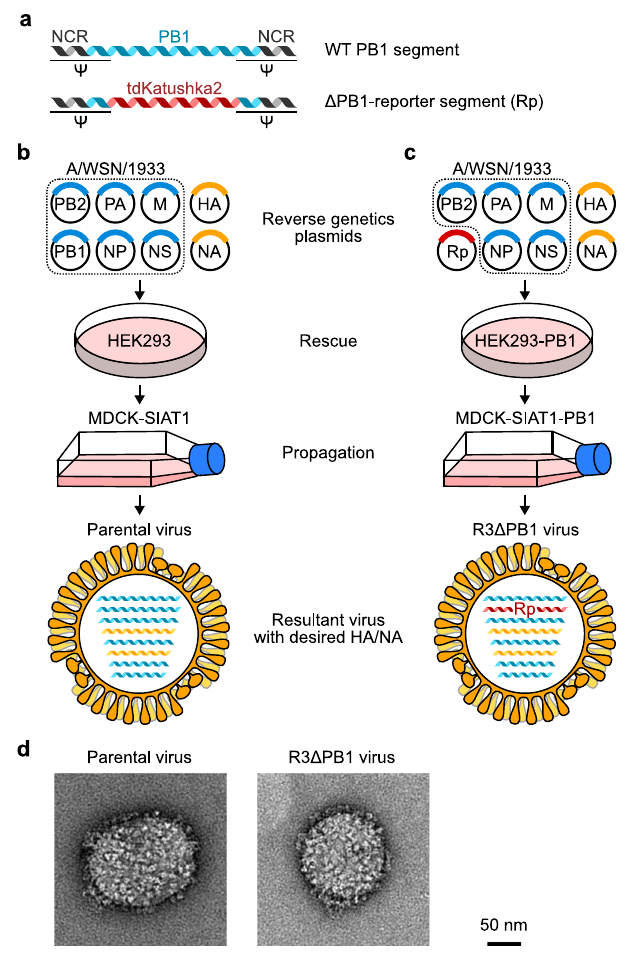
Fig. 1 Development of replication-restricted reporter (R3) Δ PB1 in fl uenza A virus. a Design of engineered PB1 segment encoding fl uorescence reporter tdKatushka2. b , c Rescue of parental wild-type molecular clone ( b ) and R3 Δ PB1 ( c ) viruses using reverse genetics of eight plasmid system with HA and NA segments of virus of interest and internal gene segments of A/ WSN/1933. PB1 segment of A/WSN/1933 is used to rescue molecularly cloned parental viruses, while engineered PB1 segment is used for R3 Δ PB1 in fl uenza viruses. R3 Δ PB1 in fl uenza viruses require cells expressing PB1 in trans for rescue and propagation. Rp, tdKatushka2 reporter gene-encoded segment. d Negative stain electron microscopy of parental molecular clone (left) and R3 Δ PB1 (right) of A/Michigan/45/2015 (H1N1) virus. Electron microscopic experiment was performed once and representative image of each virus is